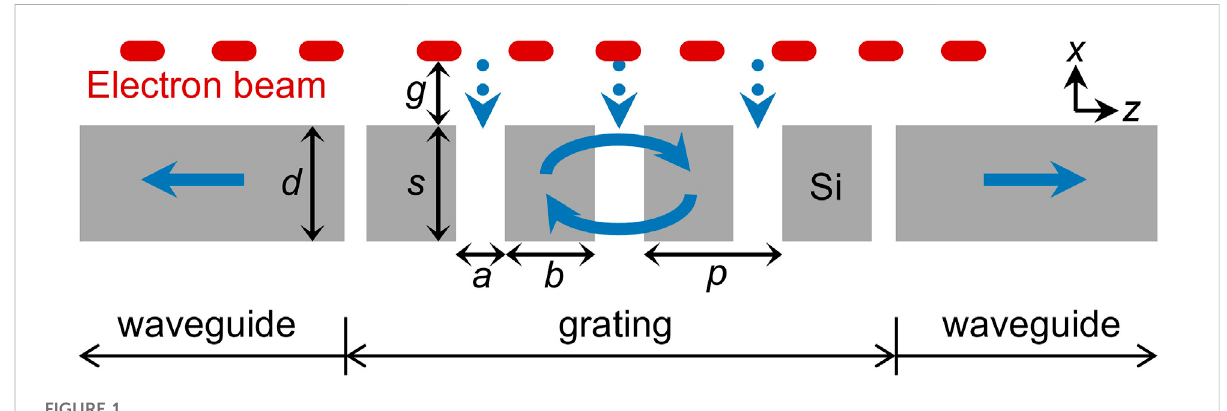
FIGURE 1 Free-electron terahertz radiation from silicon gratings with in-plane waveguide